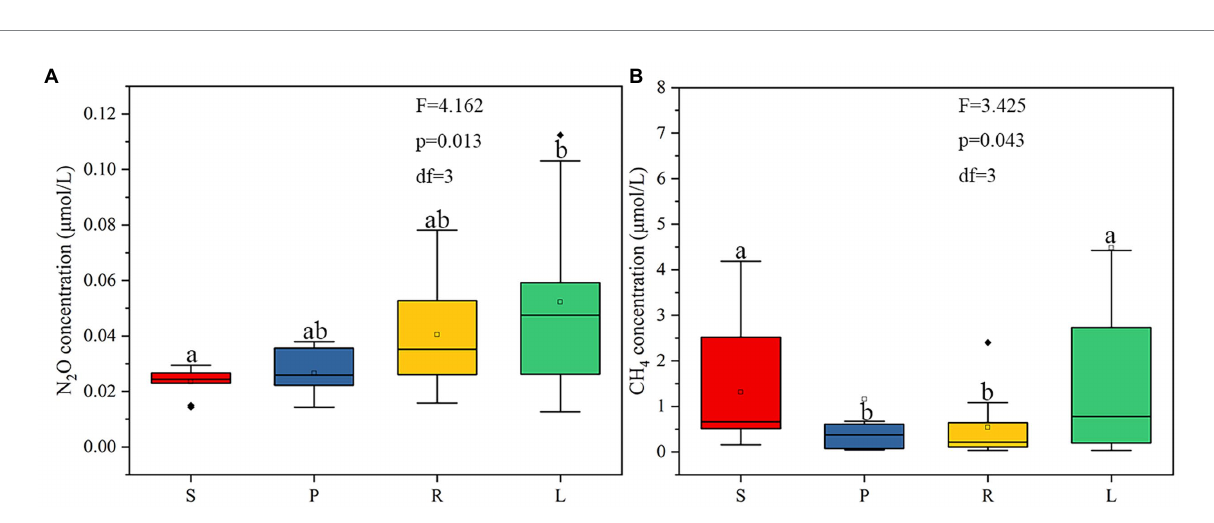
FIGURE 5 The concentration of N 2 O (A) and CH 4 (B) in four